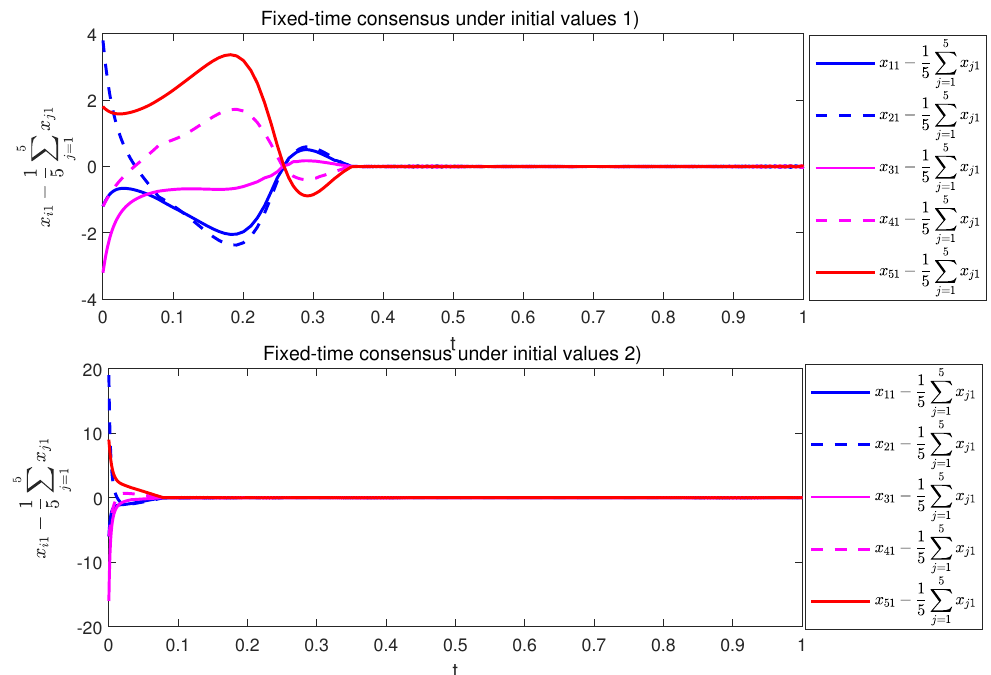
Figure 8. The trajectories of x i 1 for leaderless example under initial values (1) and (2).